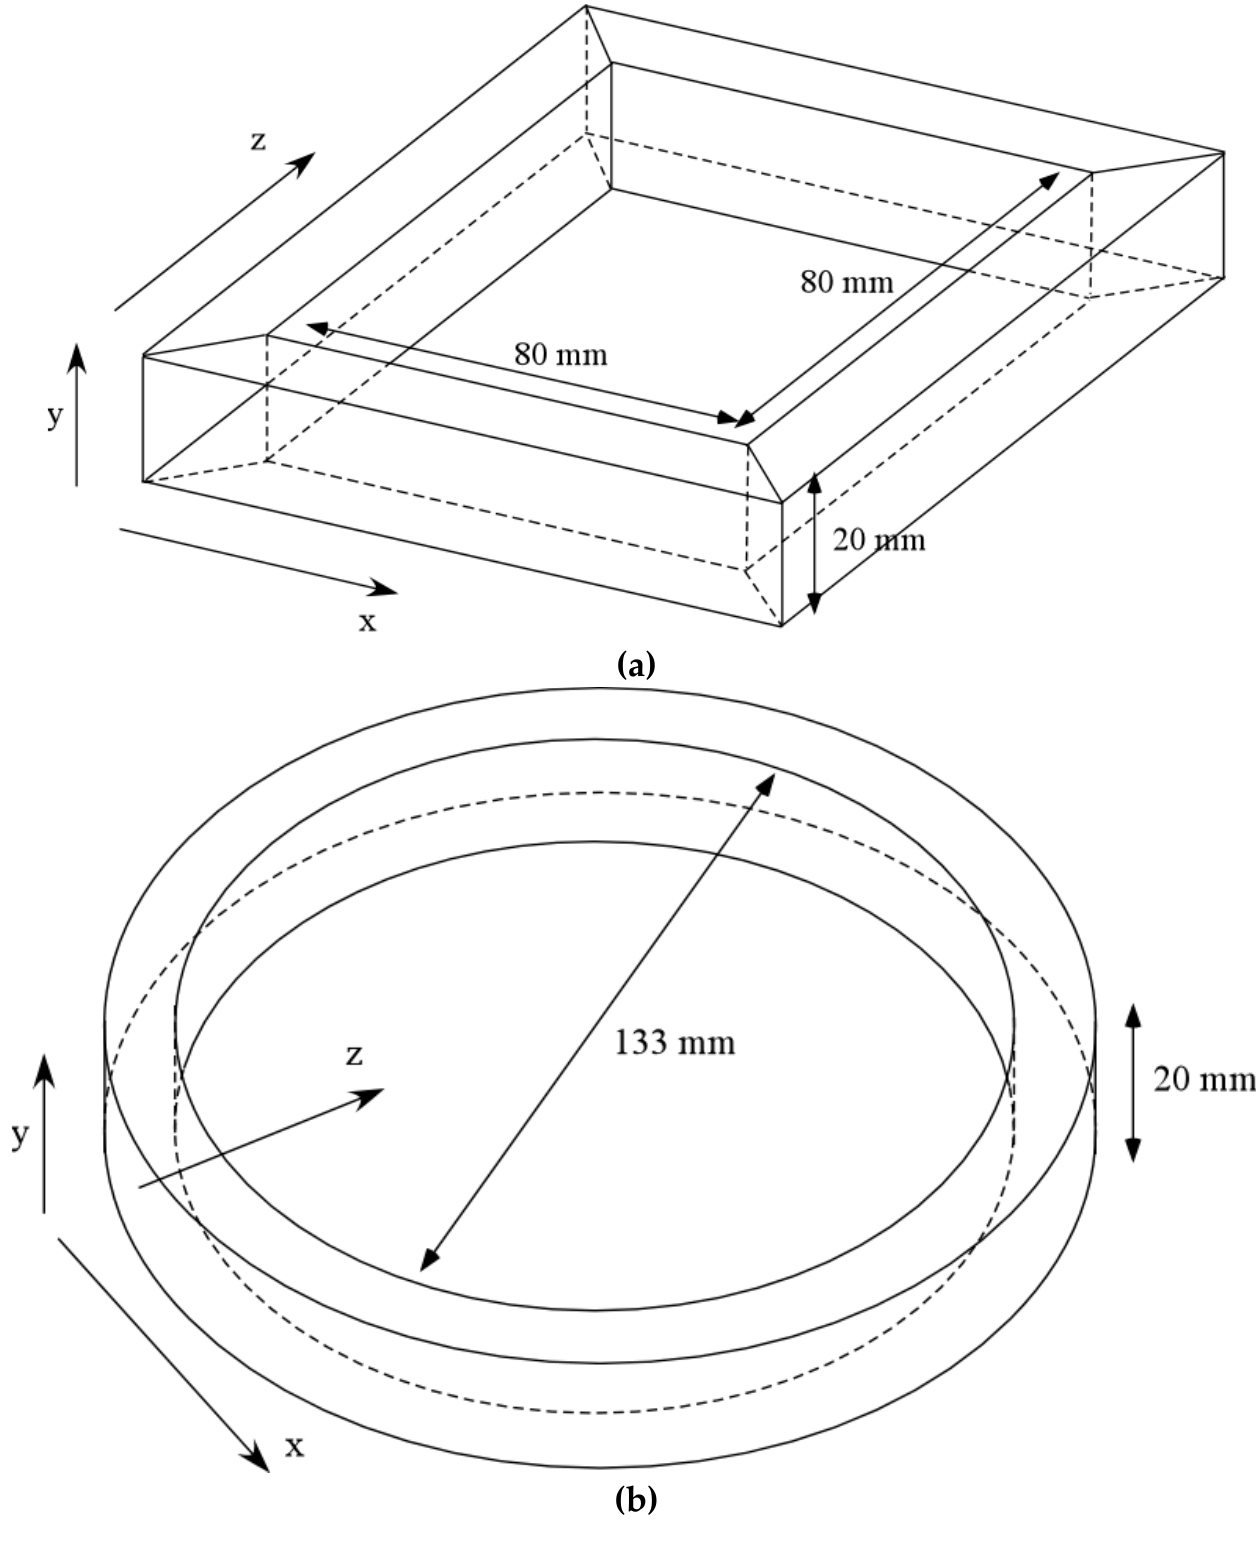
Figure 3. Three-dimensional sketch of the fluid container delimited by sidewalls of Perspex: ( a ) square container, ( b ) cylindrical container. Table 1. Specifications of MS-H280-Pro Round ceramic coated Steel Hotplate/Stirrer.